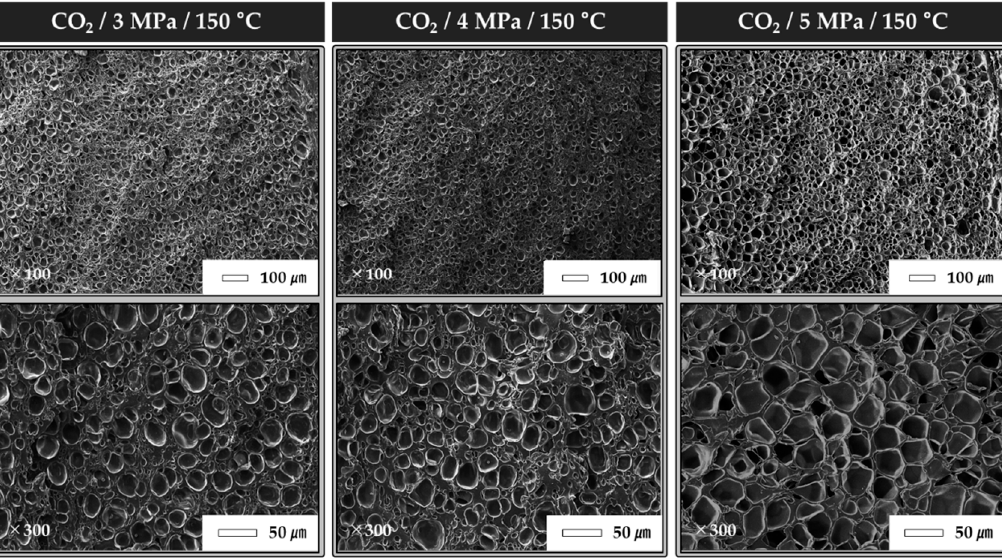
( b ) Figure 7. Experimental results for the correlation between the foaming ratio and fixing ratio ( a ) and recovery ratio ( b ) according to the foaming temperature.